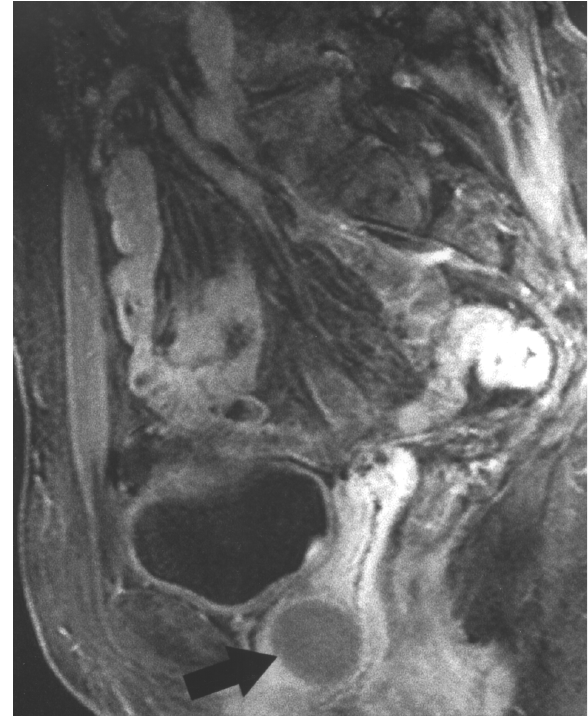
Figure 2 – Sagittal contrast-enhanced T1-weighted MRI image demonstrating a posterior periurethral mass (arrow) consistent with